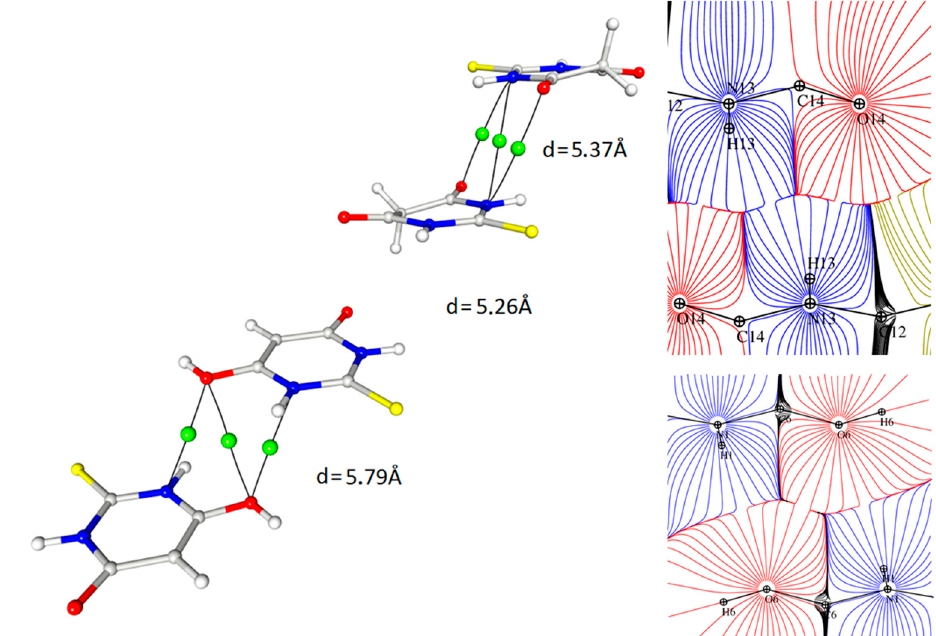
Figure 9. Contact between oxygen atoms and nitrogen atoms of the TBA ring with critical points marked and the representation of the same interaction in the image of atomic basins (d values are the distances between ring centroids).